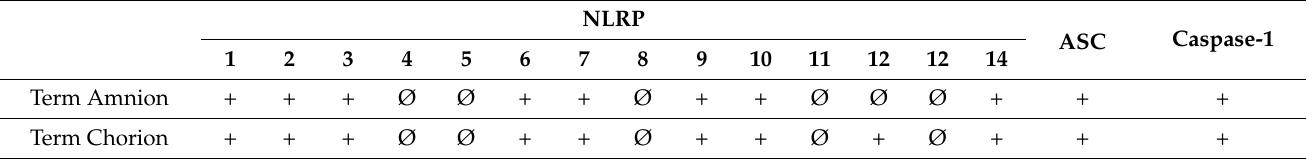
Table 1. Expression of the NRLP family in human FM. The mRNA expression of the 14 NLRPs, ASC and caspase-1 was investigated by RT-qPCR in terms of human amnion and chorion. “+” indicates the presence of the transcripts, and “Ø” indicates the absence of RNA